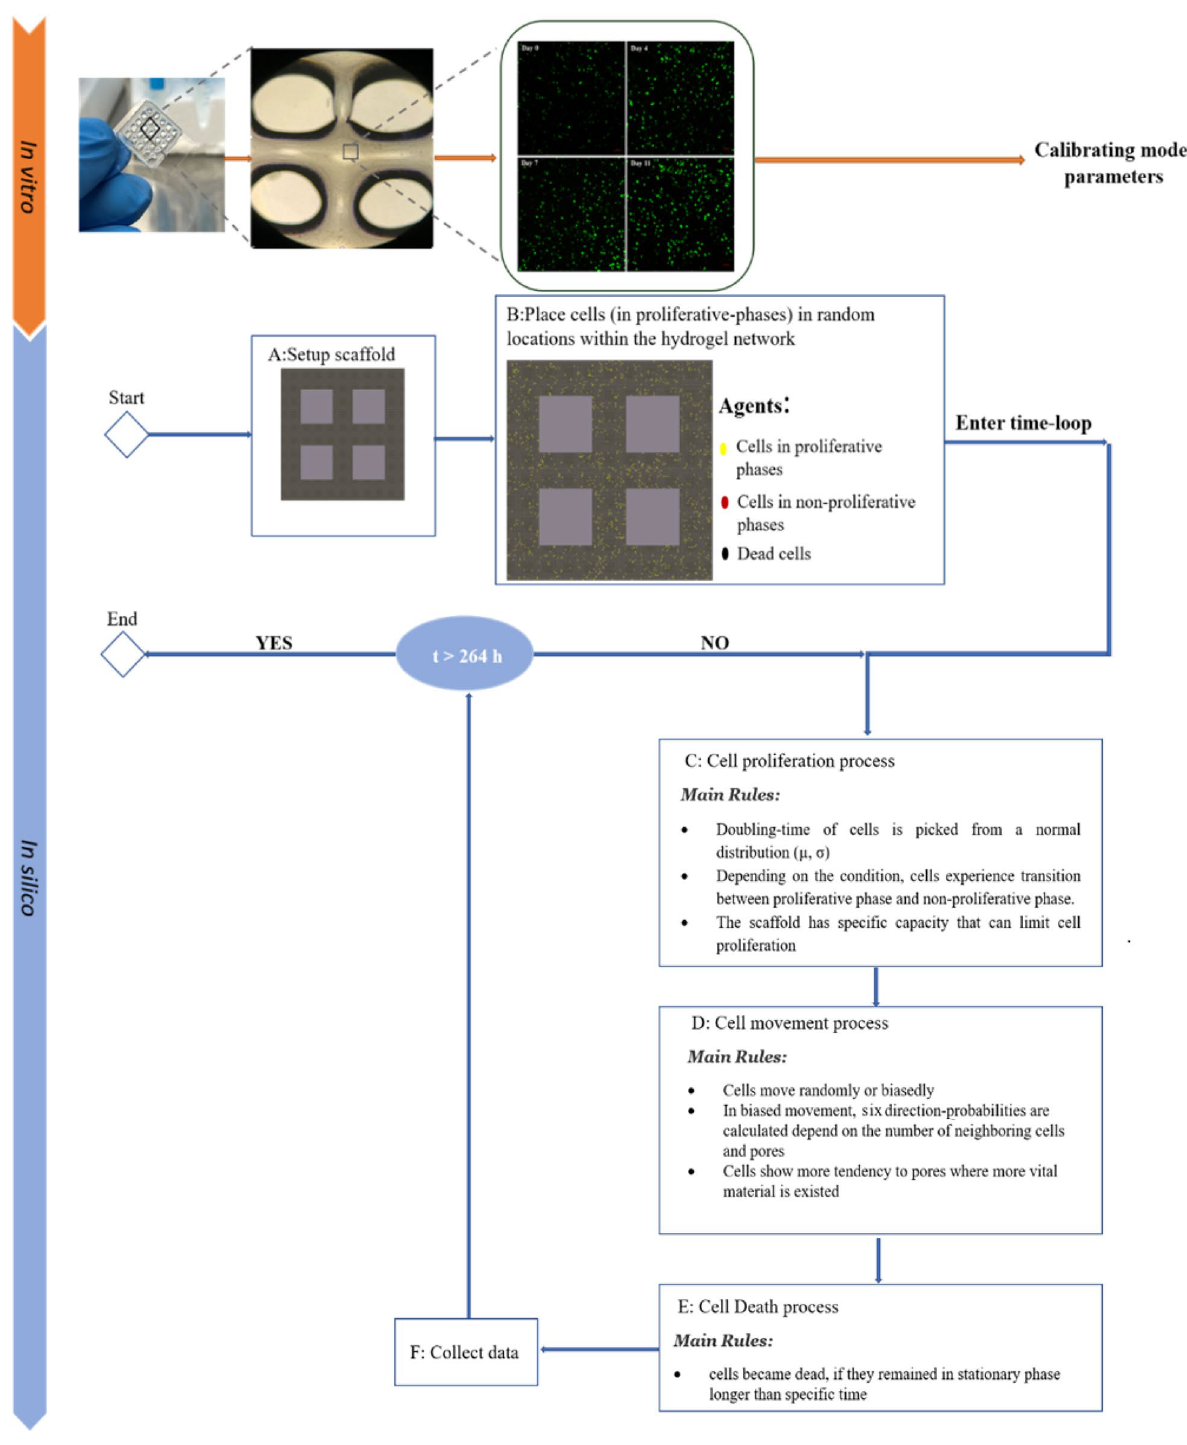
Figure 9. Main steps in in-vitro and in-silico